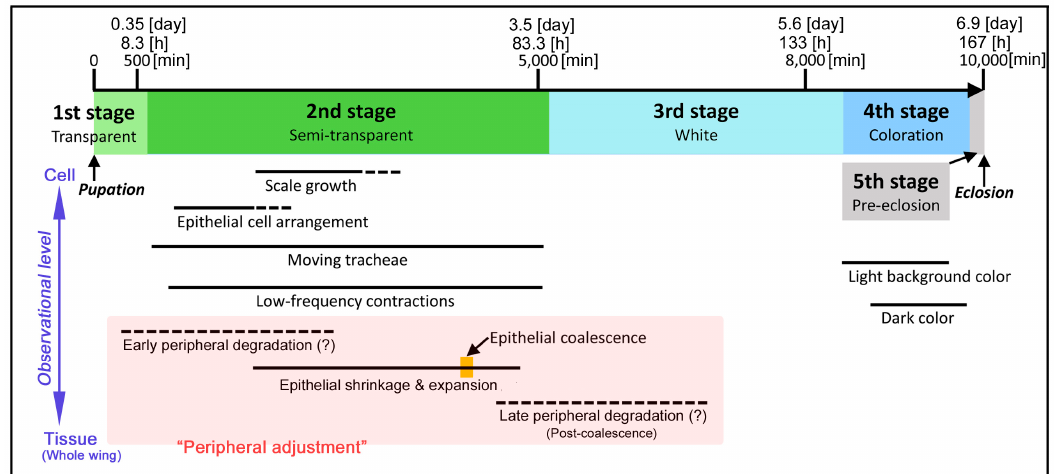
Figure 15. Time table of pupal wing development based on the present observations. Rough stages and time periods were indicated, assuming that the entire time span is approximately 10,000 minutes or 7 days. Several events of the epithelial movement and degradation are collectively called the peripheral adjustment, but it likely involves changes of the entire wings. Broken lines indicate that no clear observation was made.